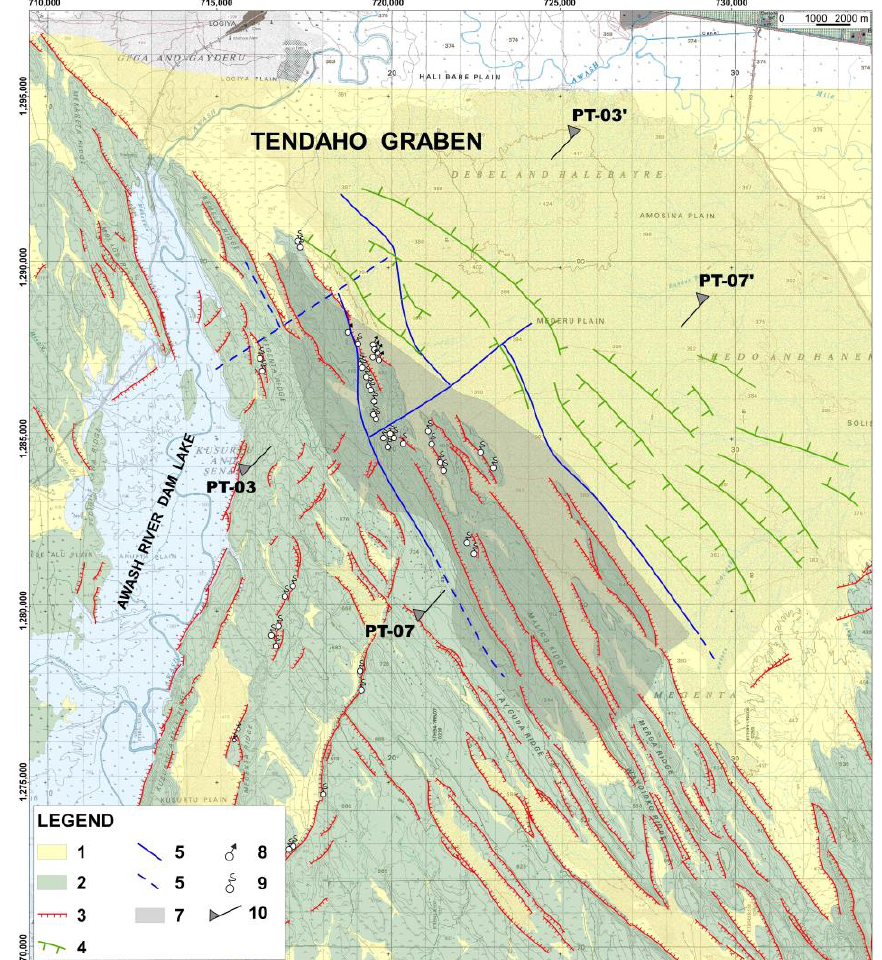
Figure 2. Geological map of the Alalobeda geothermal play. Young sedimentary deposits (1); basaltic rocks of the Afar Stratoid Series (2); main faults inferred from geological (3), gravity (4) and magnetotelluric (5) investigations; poorly defined faults (6); positive Bouguer anomaly area (7); hot spring (8); fumarole/steaming ground (9); resistivity cross-sections (PT-03 and PT-07) of Figure 3 (10).